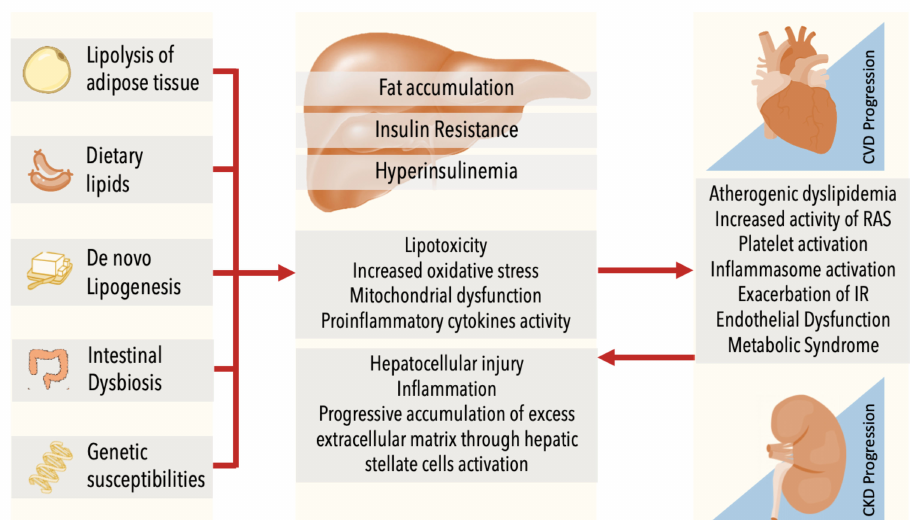
Figure 1. NAFLD, CKD and CVD share common risk factors. Lipolysis of adipose tissue, dietary lipids, de novo lipogenesis, dysbiosis and genetic susceptibilities act in parallel, contributing to fat accumulation. It leads to insulin resistance (IR), enhancing liver trygliceride accumulation and results in compensatory hyperinsulinemia which increases the hepatic fatty acid uptake, alters triglycerides transportation and inhibits liver β -oxidation. There is an intensification of the pro-inflammatory cytokine activity that is associated with oxidative stress-mediated lipotoxicity, increased activity of RAS, platelet activation, inflammasome activation and mitochondrial dysfunction. These processes contribute to further exacerbation of IR, hepatocellular injury, inflammation and the progressive accumulation of excess extracellular matrix through hepatic stellate cells activation. NAFLD: Non- alcoholic Fatty Liver Disease, CKD: Chronic Kidney Disease; CVD: Cardiovascular Disease; IR: insulin resistance; RAS: renin-angiotensin-aldosterone